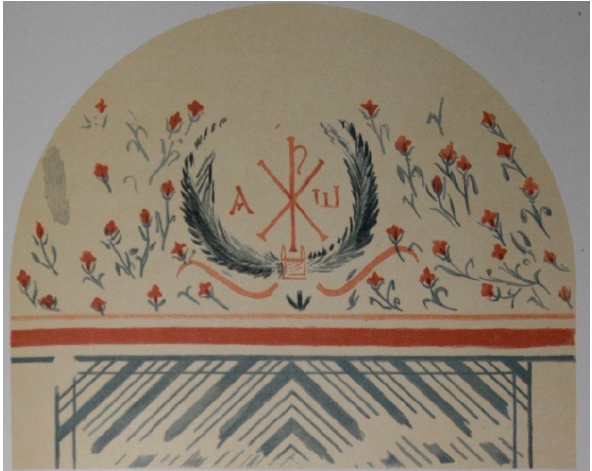
Figure 8. Sardis, “Painted Tomb” (Appendix A.2 T2), painting of west wall. © Archaeological Exploration of Sardis/President and fellows of Harvard College.